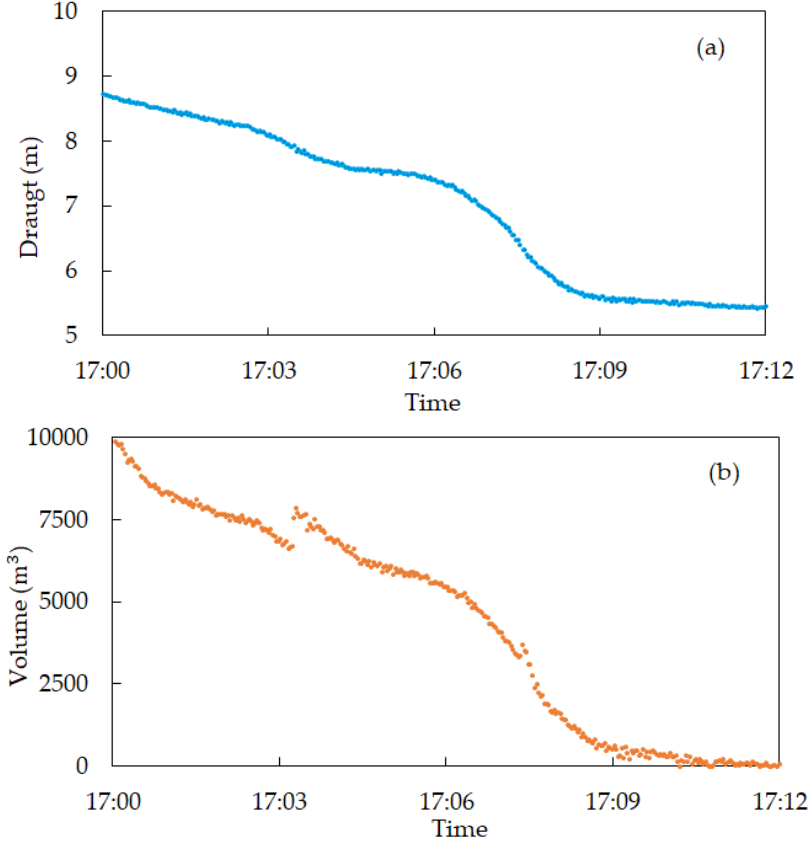
Figure 7. The process of dumping sediment over time ( a ) change of draught ( b ) change of sediment volume.